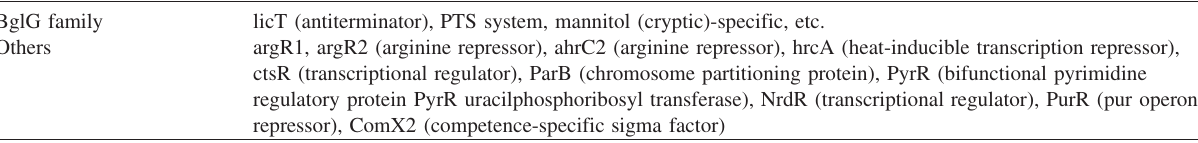
Table 6 Other prokaryotic transcription factors. BglG family licT (antiterminator), PTS system, mannitol (cryptic)-specific, etc.